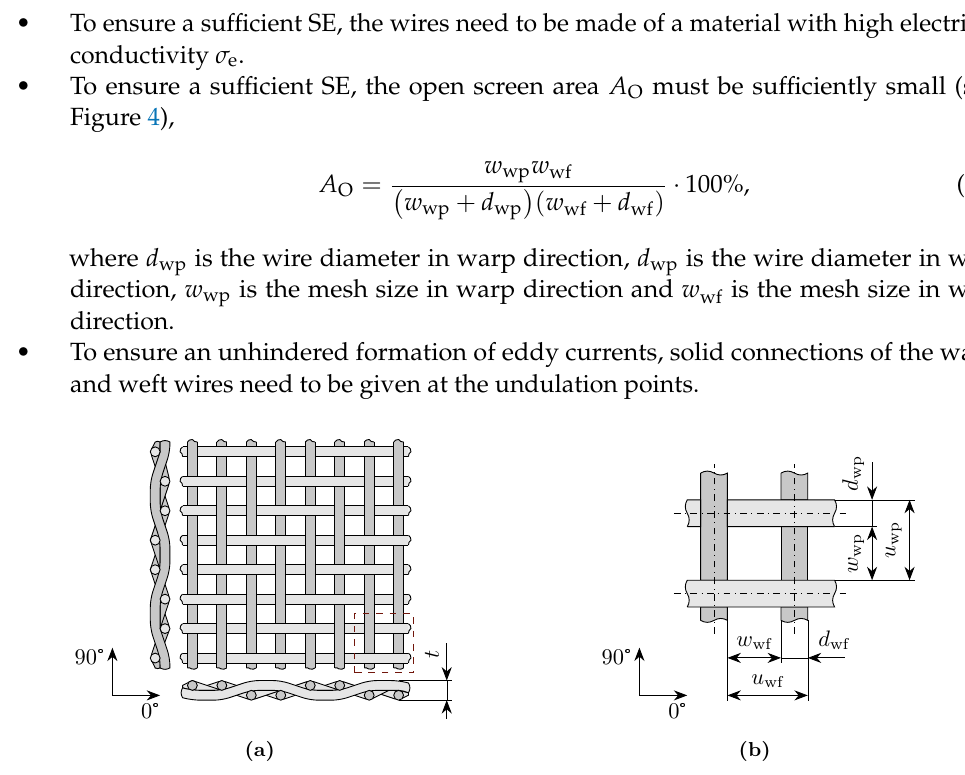
Figure 4. Schematic representation of a metal wire mesh according to DIN ISO 9044 [25]: ( a ) Twill binding 2/2, ( b ) mesh size w , wire diameter d and pitch u